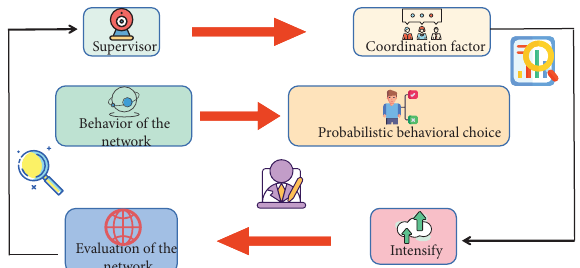
Figure 1: A neural network-based robotic arm control method and